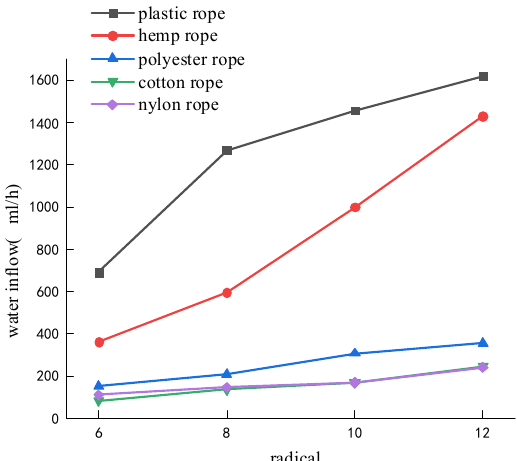
Figure 19. A seepage effect diagram of the nylon rope fiber bundle.